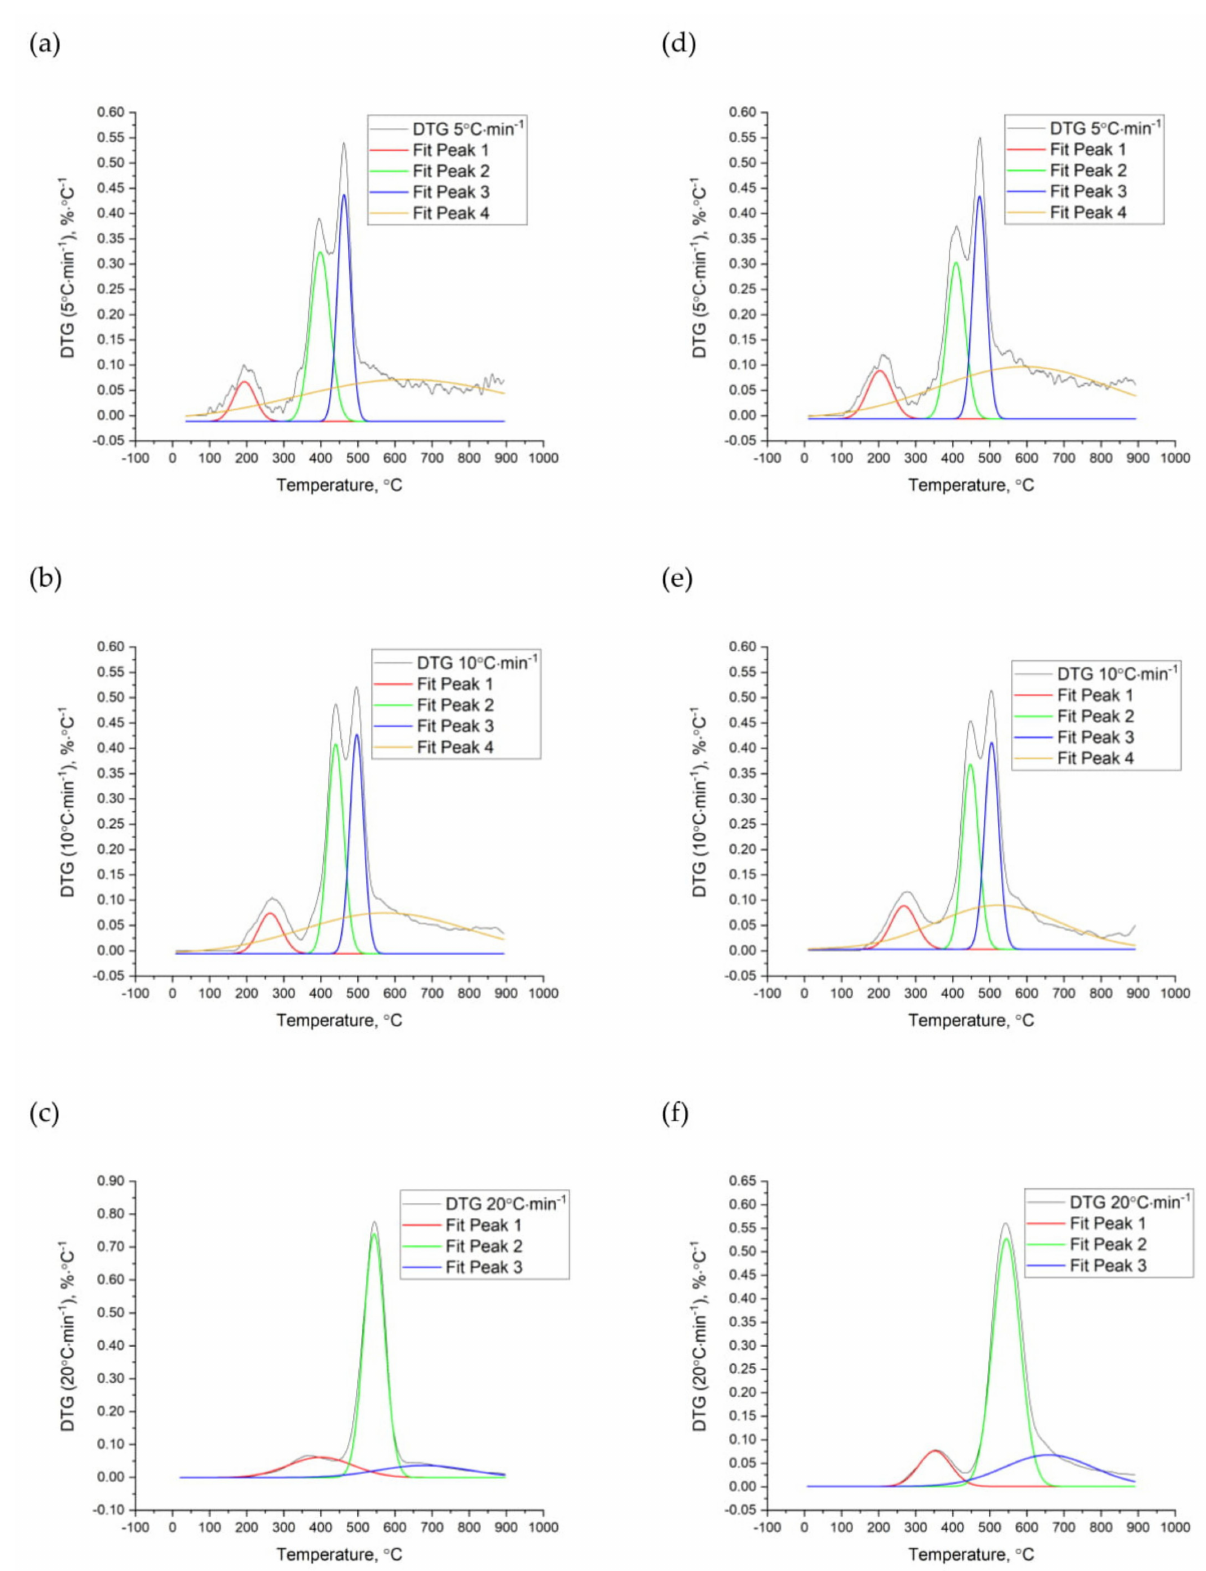
Figure 5. Peak analysis of the WS ( a – c ) and HS ( d – f ) pyrolysis process at a heating rate β of 5 ◦ C · min − 1 , 10 ◦ C · min − 1 , and 20 ◦ C · min − 1